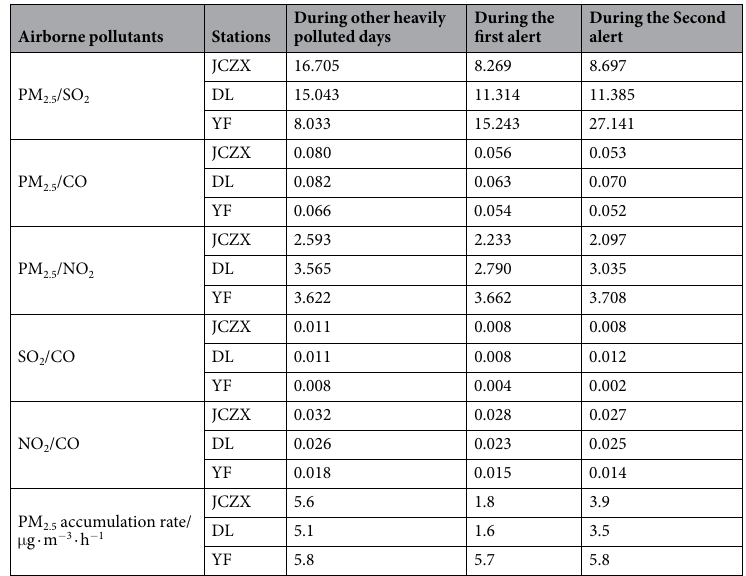
Table 2. Ratios between different air pollutants during different heavily polluted episodes in Beijing. PM 2.5 accumulation rate = (Max PM 2.5 concentration- 150 μ g · m − 3 )/polluted